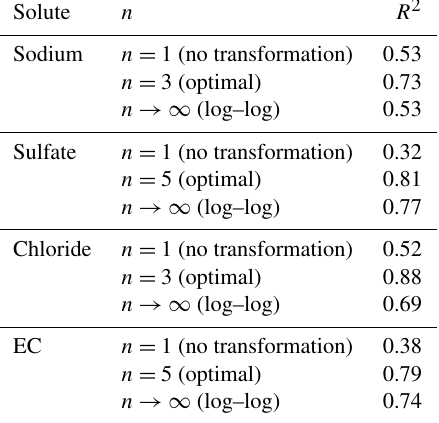
Table 2. Coefficient of determination ( R 2 ) calculated for n = 1 (no transformation), n = optimal value for two-sided affine power scal- ing relationship (Fig. 3) and n → ∞ (log–log space) for each ion and for electrical conductivity (EC). Note that the R 2 is computed from transformed values.